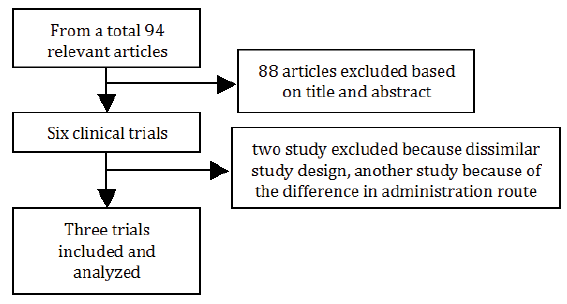
Figure 1. Algorithm of the study selection and inclusion in meta-